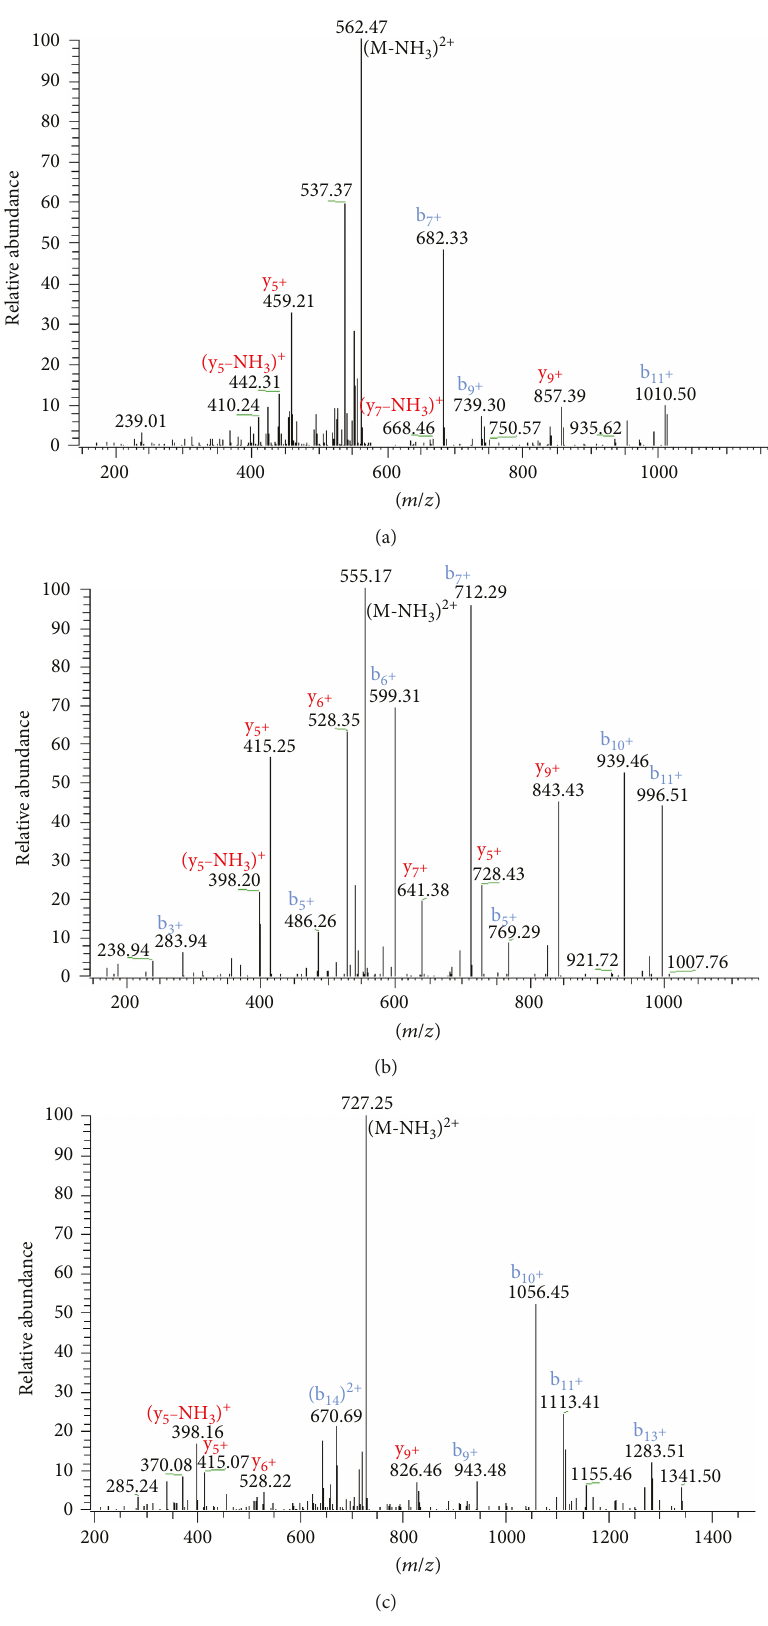
Figure 5: Annotated tandem mass (MS/MS) fragmentation spectrum of (a) Caeridin-1, (b) S5-Caeridin-1, and (c) Caeridin-a1. The observed b ions and y ions are labelled in blue and red,